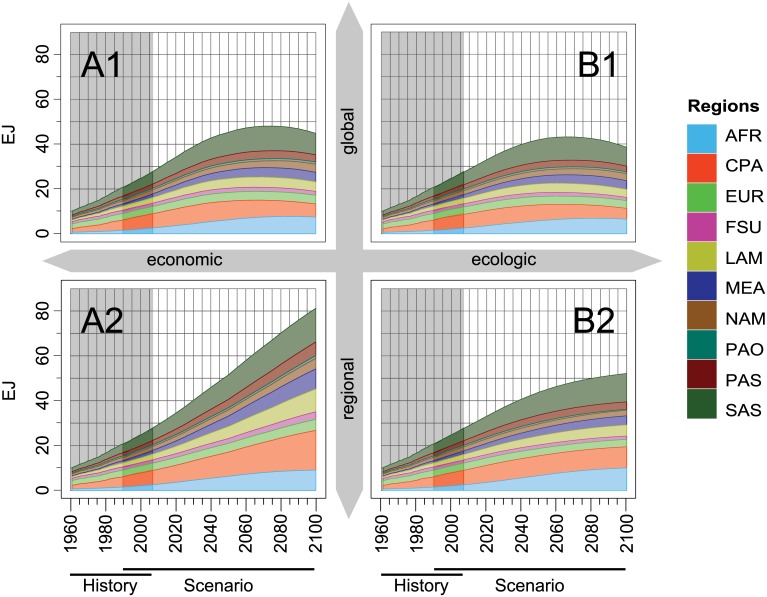
Total food energy demand projections per region over time for 4 SRES scenarios (1018 Joule a−1).Figures consist of historical data by FAO (1961–2007, “History”), respective projections (1990–2100, “Scenario”).